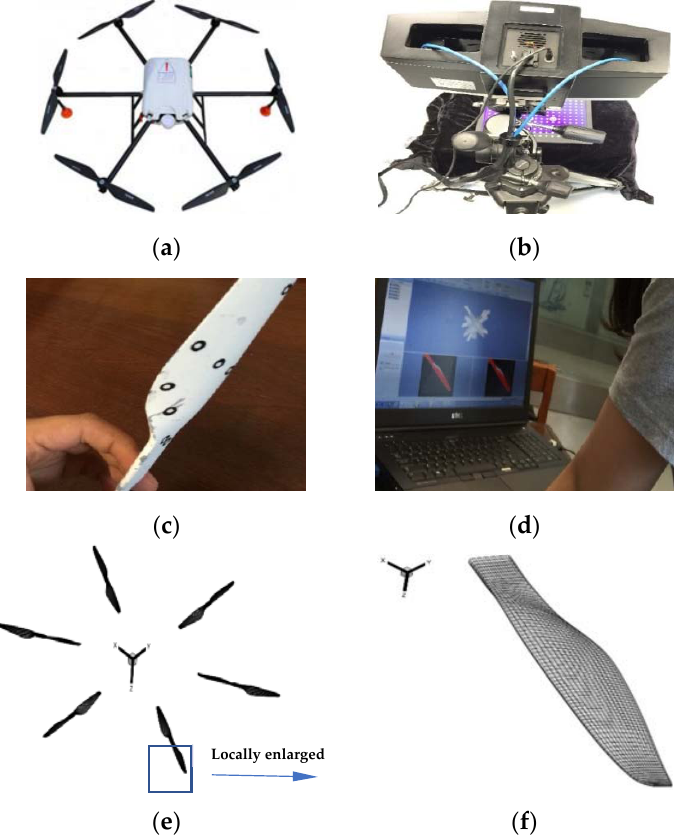
Figure 2. Scanning and reconstruction of crucial components of multi-rotor plant protection UAV: ( a ) Airframe structure of multi-rotor plant protection UAV; ( b ) Optimscan5-2015011K05 scanner; ( c ) Closely markers in places with significant curvature changes; ( d ) Synthesis of multi-angle surface point clouds by a team member; ( e ) Schematic diagram of wall structured mesh for vital components; ( f ) Partially enlarged view of the structured mesh model of the rotor component.